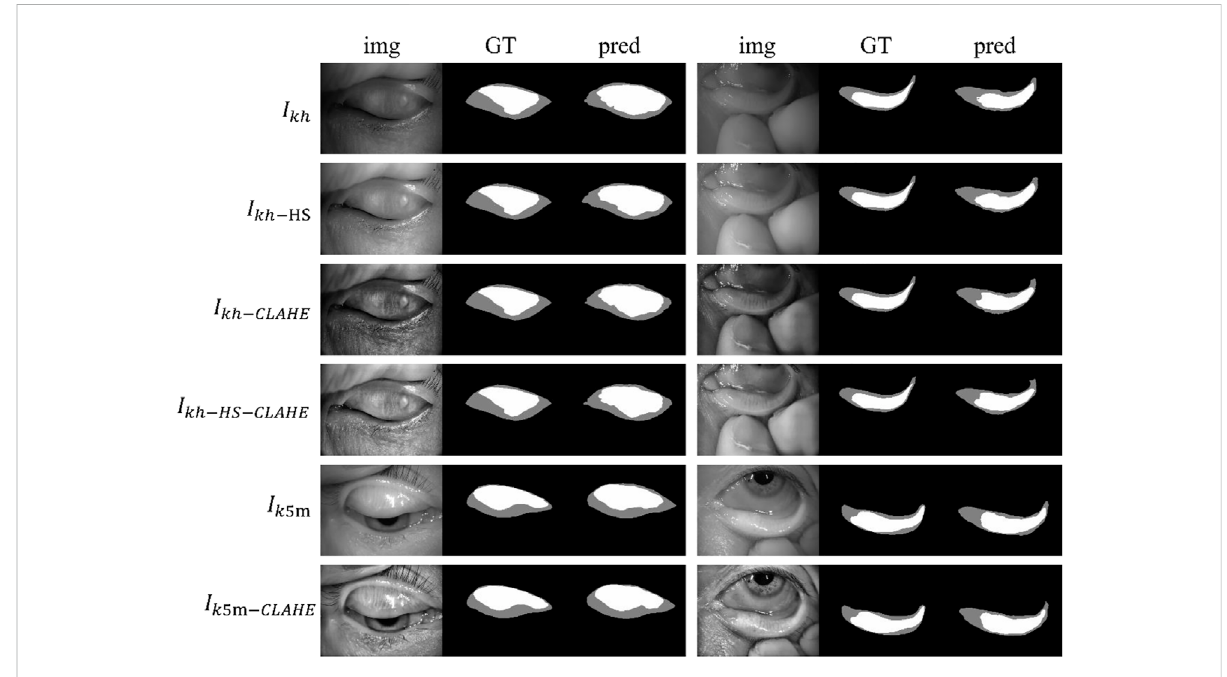
FIGURE 4 Examples of segmentation results for external and internal testing images. Img, GT, and pred represent input images, ground-truth masks, and predicted segmentation masks, respectively.